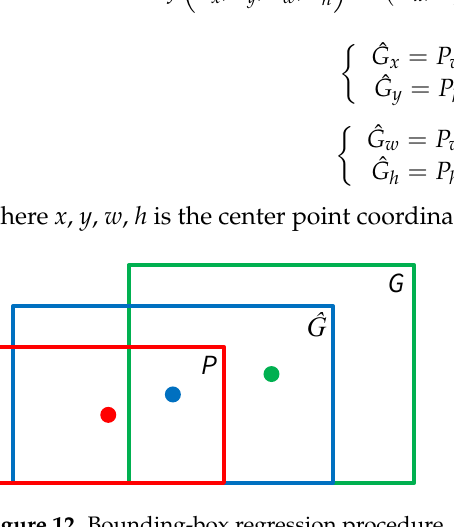
Figure 12. Bounding-box regression procedure.